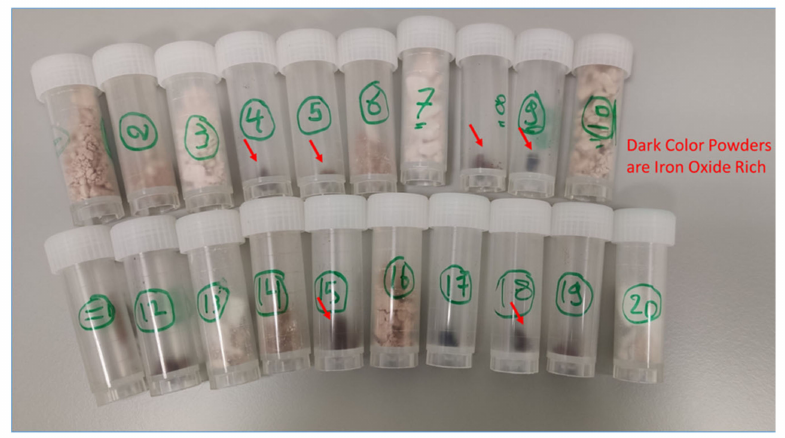
Figure 6. Image for the prepared adsorbents using the model described in Table